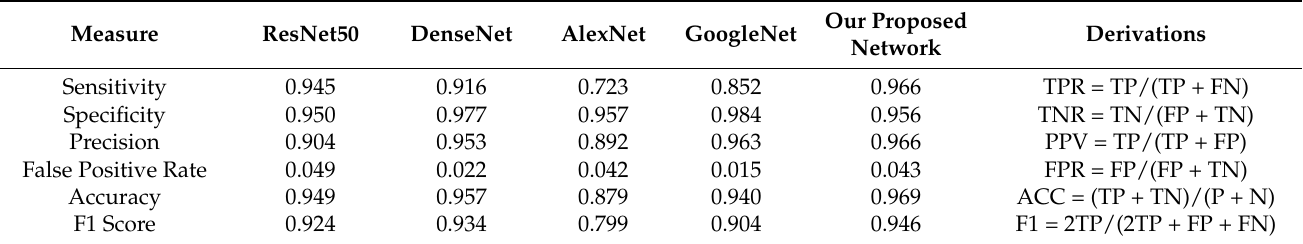
Table 2. Comparison between our proposed network and other CNN pre-train models in term of performance metrics.